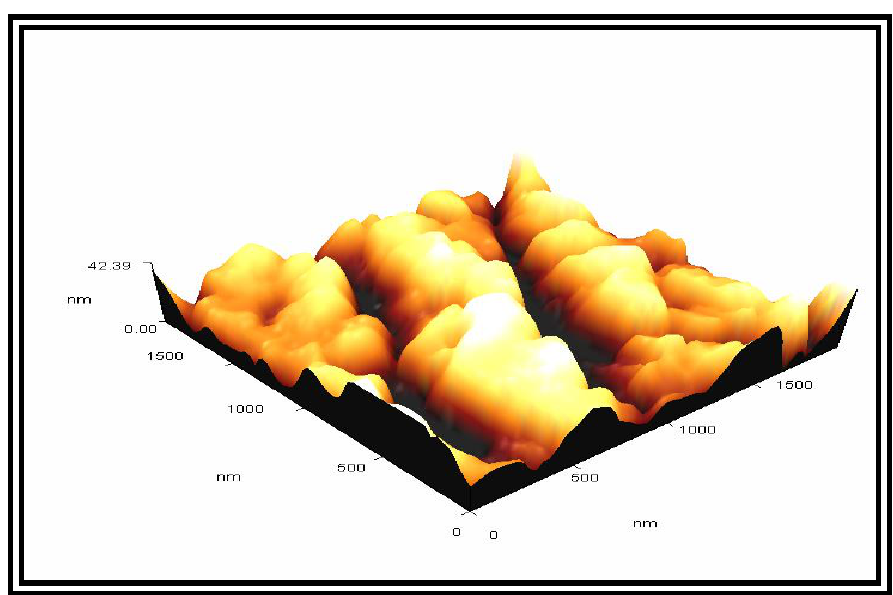
Fig(4b):3D AFM Image of copper oxide thin film.